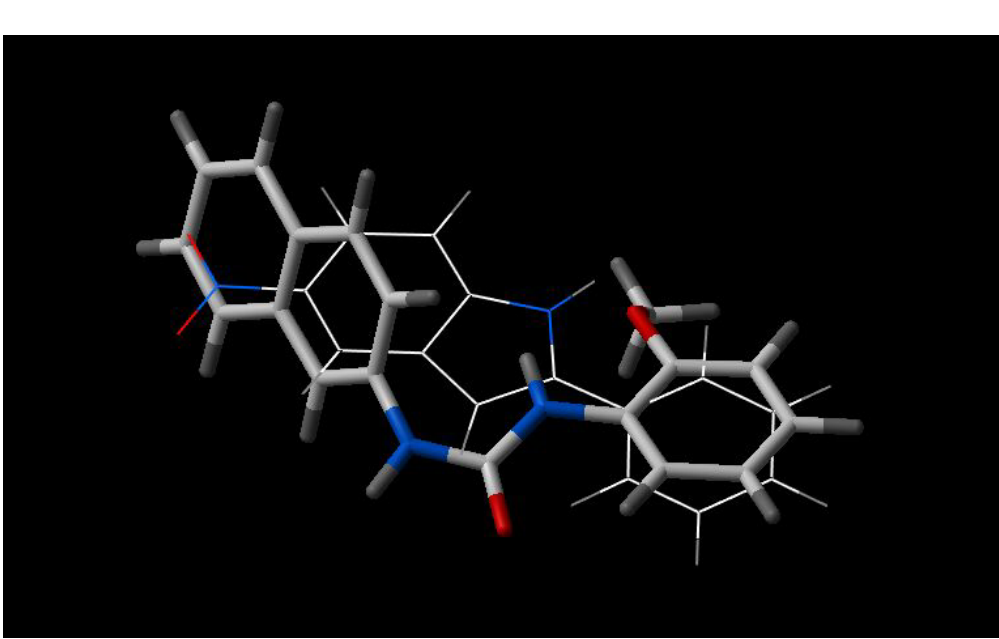
Figure 3. Best fit of optimised INF 271 (sticks) and INF 55 (wireframe)